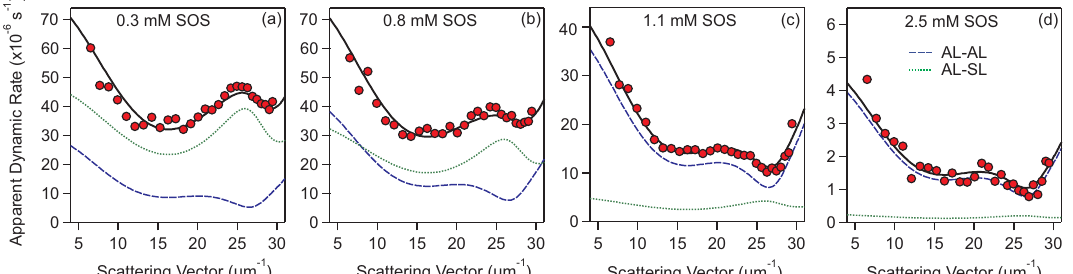
Figure 1. Apparent dynamic rates for the mixture of AL and SL particles as a function of the magnitude of the scattering vector Q at ( a ) 0.3 mM, ( b ) 0.8 mM, ( c ) 1.1 mM, and ( d ) 2.5 mM SOS. The symbols are experimentally determined apparent rates, while full line represents the fit to Equation (4). The dotted and dashed lines represent the contribution of AL-AL and AL-SL aggregates, respectively. The particle concentrations used are 0.50 mg/L (3.4 · 10 − 14 m − 3 ) and 0.23 mg/L (3.3 · 10 − 14 m − 3 ) for AL and SL,